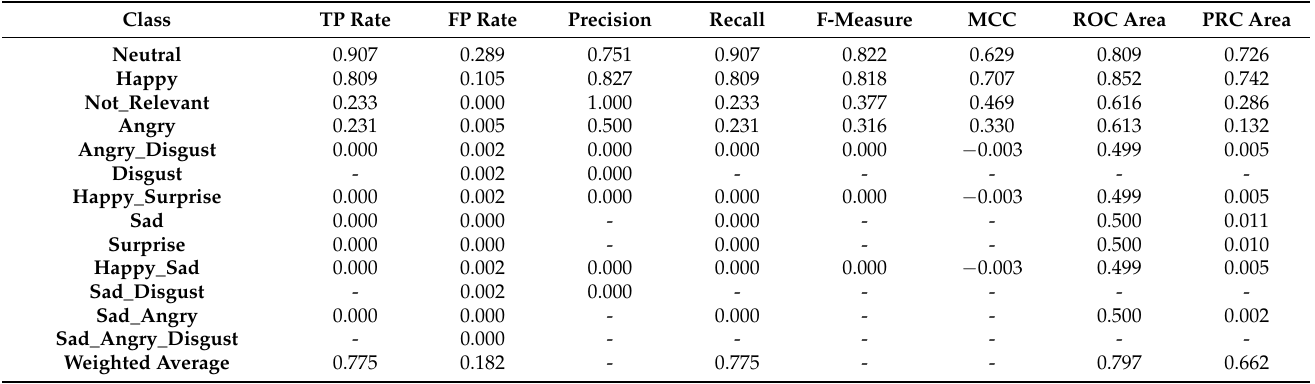
Table 8 represents the precise accuracy by class using the tetrad of feature selection technique in combination with LL, and its graphical representation is shown in Figure 9. Table 8. Detailed accuracy by class (tetrad feature selection